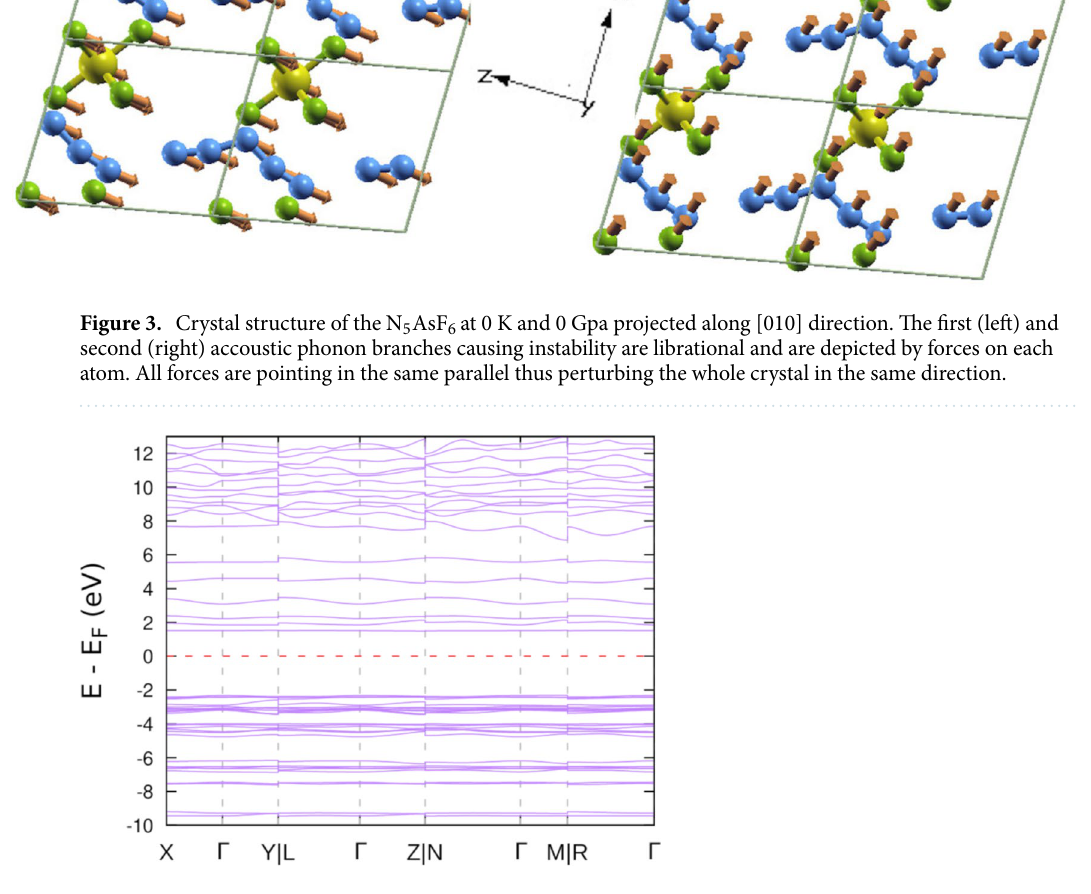
Figure 4. Electronic band structure of the N 5 ASF 6 at 0 K and 0 GPa. The solid is an insulator with a direct band gap of 3.8